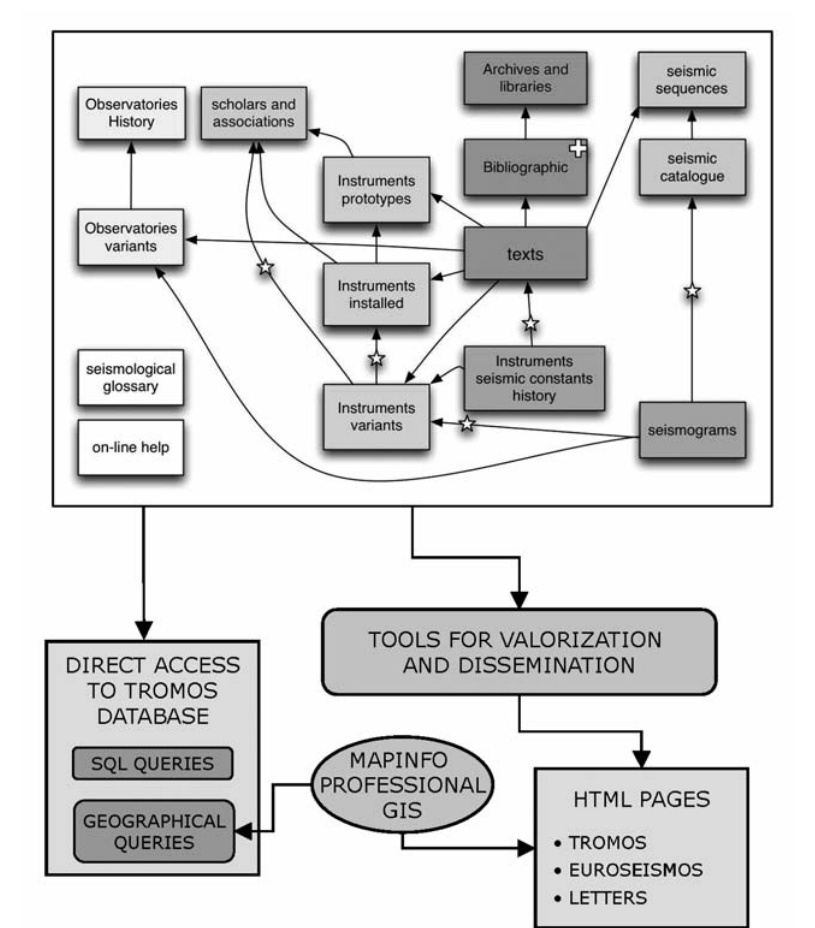
Fig. 1. Simplified scheme of the structure of the TROMOS database and the relations between the different files. Although it can be managed in a relational way, in this case a hierarchical structure of the links has been preferred. The levels of the hierarchy correspond to the respective positions of the files in the figure. In particu- lar, for the observatories there are two files: the one of the observatory’s history, in which all the information is summarised as well as the history of the observatory and the file of its variants (name, location, etc.). As regards the instruments, there are three files connected with one another: the file of the prototypes (the idea and the description of the instrument even if never actually made), that of the instruments actually made and lo- cated in the observatories and the file of the variants of the instruments devised (modifications, re-location etc.). One file collects the information related to scholar and the association. Two files collect the information relat- ing to the earthquakes: one relating to the whole sequence and one relating to each earthquake that is the refer- ence for the file cataloguing the seismograms. The bibliographic file with the related texts of the sources and the information relating to the archive or the li- brary of conservation, guarantees the documentary support to the information contained in the variation files on observatories, instrument variants, prototypes, scholars, seismic sequences, and seismological glossary. The database is potentially set up for sharing its files with other complementary files such as the CFTI4Med (Guidoboni et al., 2007) is indicated on the right of the figure. Different types of interface and interactions with other information technology tools allow for the use of the data in different modalities and a wide range of sci- entific and cultural 740